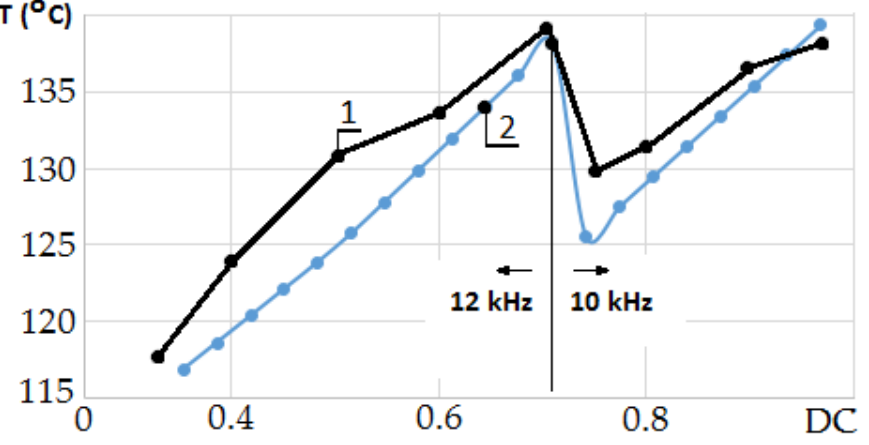
Figure 20. Comparison between analytically (2) and experimentally (1) estimated temperature, according to Figure 8.